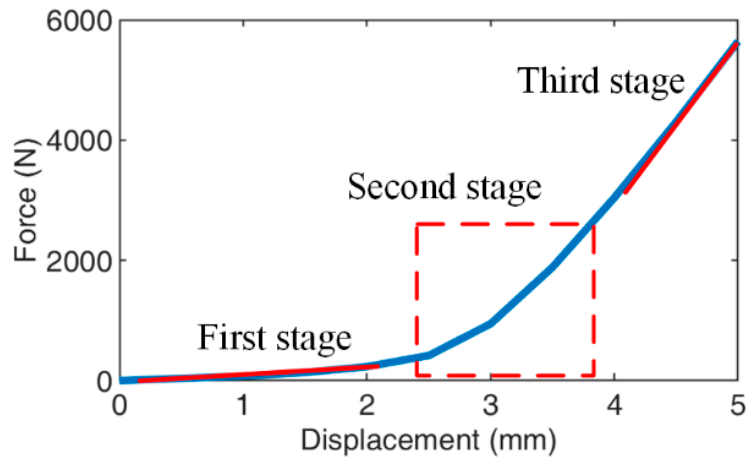
Figure 11. Load–deformation curve.